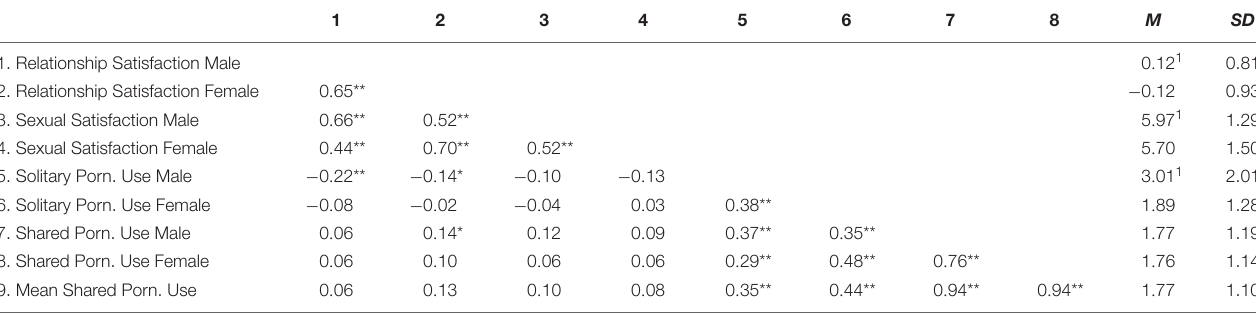
TABLE 1 | Summary of the correlations, means, and standard deviations of the focal variables for Study 1 ( N = 200 couples). 1 2